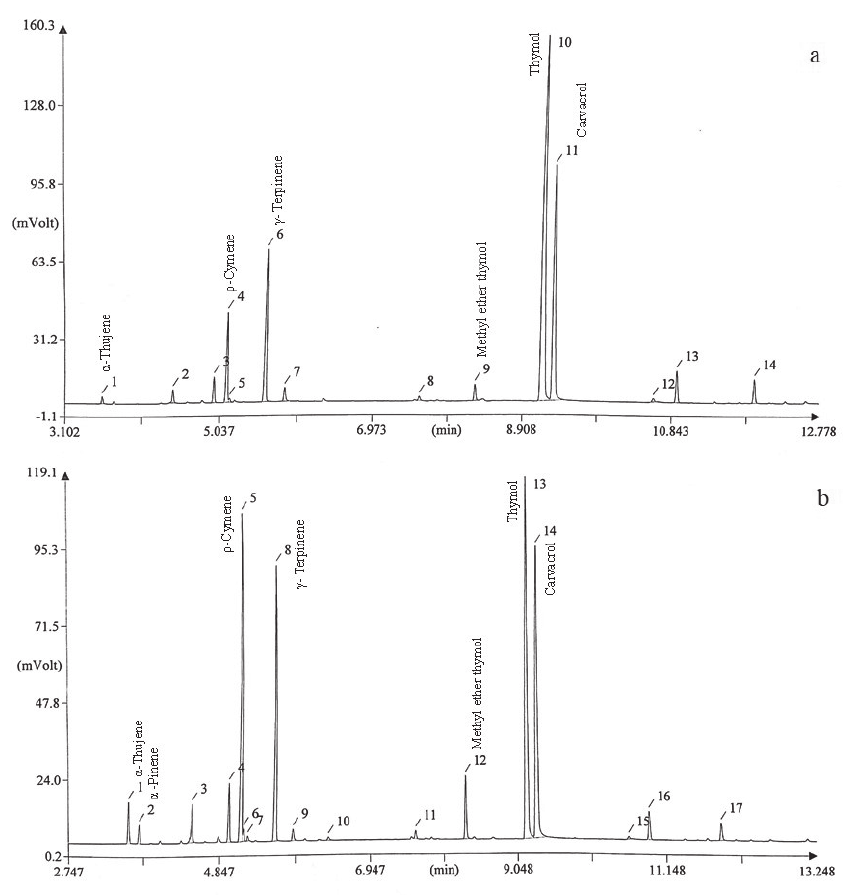
Figure 8. GC-MS chromatogram of tetraploid (a) and induced octaploid (b) of Satureja